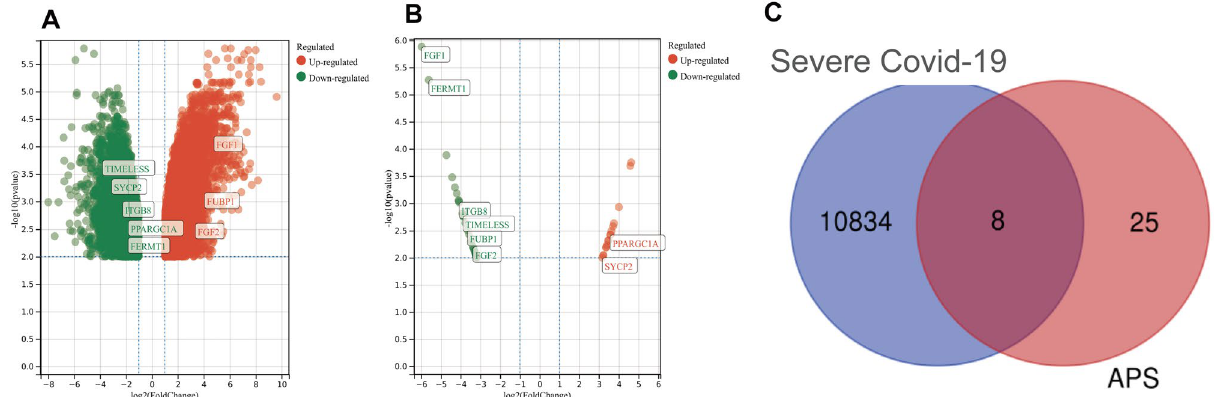
Figure 2. Analysis of differentially expressed genes between severe COVID-19 and APS patients. ( A ) Volcano- plot representation of the differentially expressed genes (DEGs) in severe COVID-19 patients. Green indicates that the genes were up-regulated, and red means that the genes were down-regulated. ( B ) Volcano-plot representation of the DEGs in APS patients. Y-axis represents the P -value (-log10 scale) and X-axis represents the fold change (log 2 scale). ( C ) Representation of the common DEGs in severe COVID-19 and APS patients through a Venn diagram. 10,842 genes were included exclusively in the severe COVID-19 group; 33 genes were included exclusively in the APS group and 8 genes were common between the severe COVID-19 and APS groups. Blue circle denotes the number of DEGs in the severe COVID-19 group and pink circle denotes the number of DEGs in the APS group.